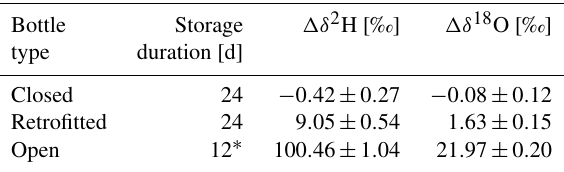
Table 1. Isotopic differences between a reference water and wa- ter samples in a closed, open and retrofitted bottle that were stored outside the ISCO autosampler during Experiment 1. Isotopic differ- ences are expressed as mean ± 1 standard deviation. Bottle Storage (cid:49)δ 2 H [ ‰ ] (cid:49)δ 18 O [ ‰ ] type duration [ d ] Closed 24 − 0 . 42 ± 0 . 27 − 0 . 08 ± 0 . 12 1 . 63 ± 0 . 15 100 . 46 ± 1 . 04 21 . 97 ± 0 . 20